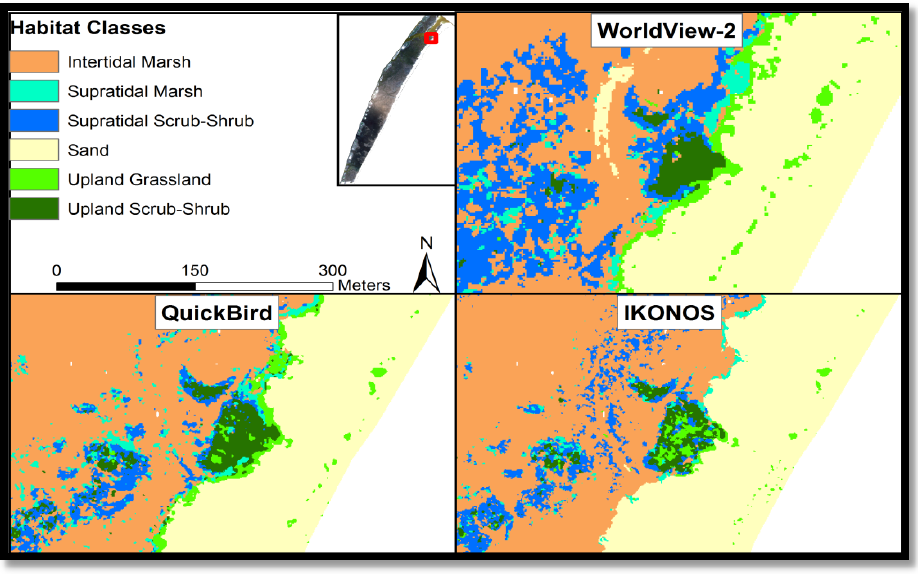
Figure 7. Supervised classification maps using WorldView-2, QuickBird, and IKONOS for an example area of Masonboro